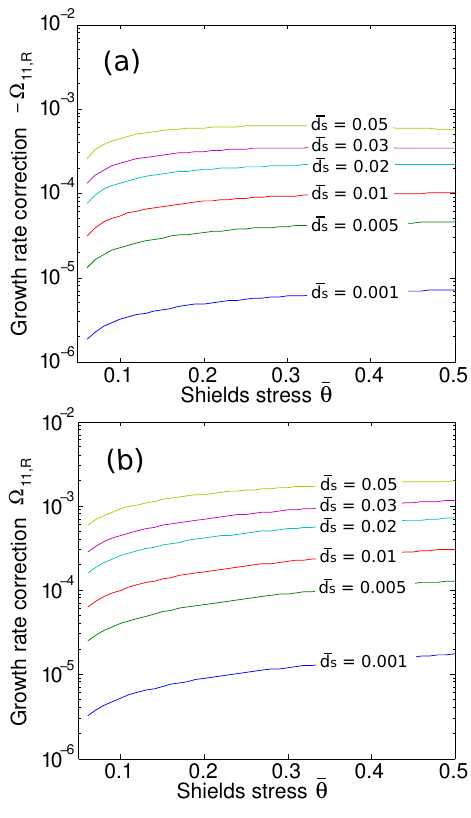
Fig. 2. (a) Temporal variability of the dimensionless discharge Q 0 (τ) and associated temporal variability of the dimensionless channel width B(τ) . (b) Values of the total bar growth rate (cid:127)(τ) for the flow event in (a) for laterally confined (dashed line) and un- confined (solid line) channels.